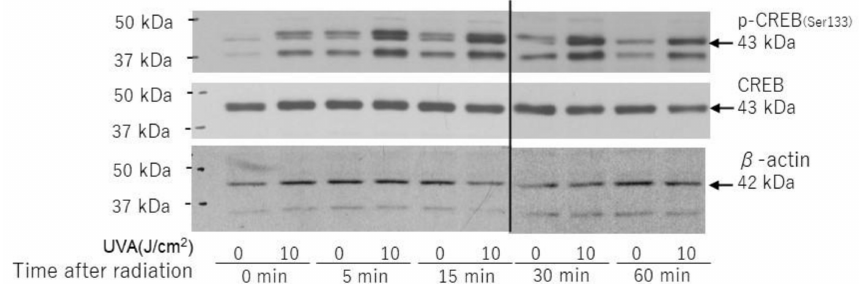
Figure 9. Effects of UVA on phosphorylation and protein levels of CREB. HDFs were exposed to UVA at the indicated doses in culture and cell lysates prepared at the indicated times post-irradiation were subjected to western blotting as described in the Materials and Methods section. Representative immunoblots from three independent experiments are